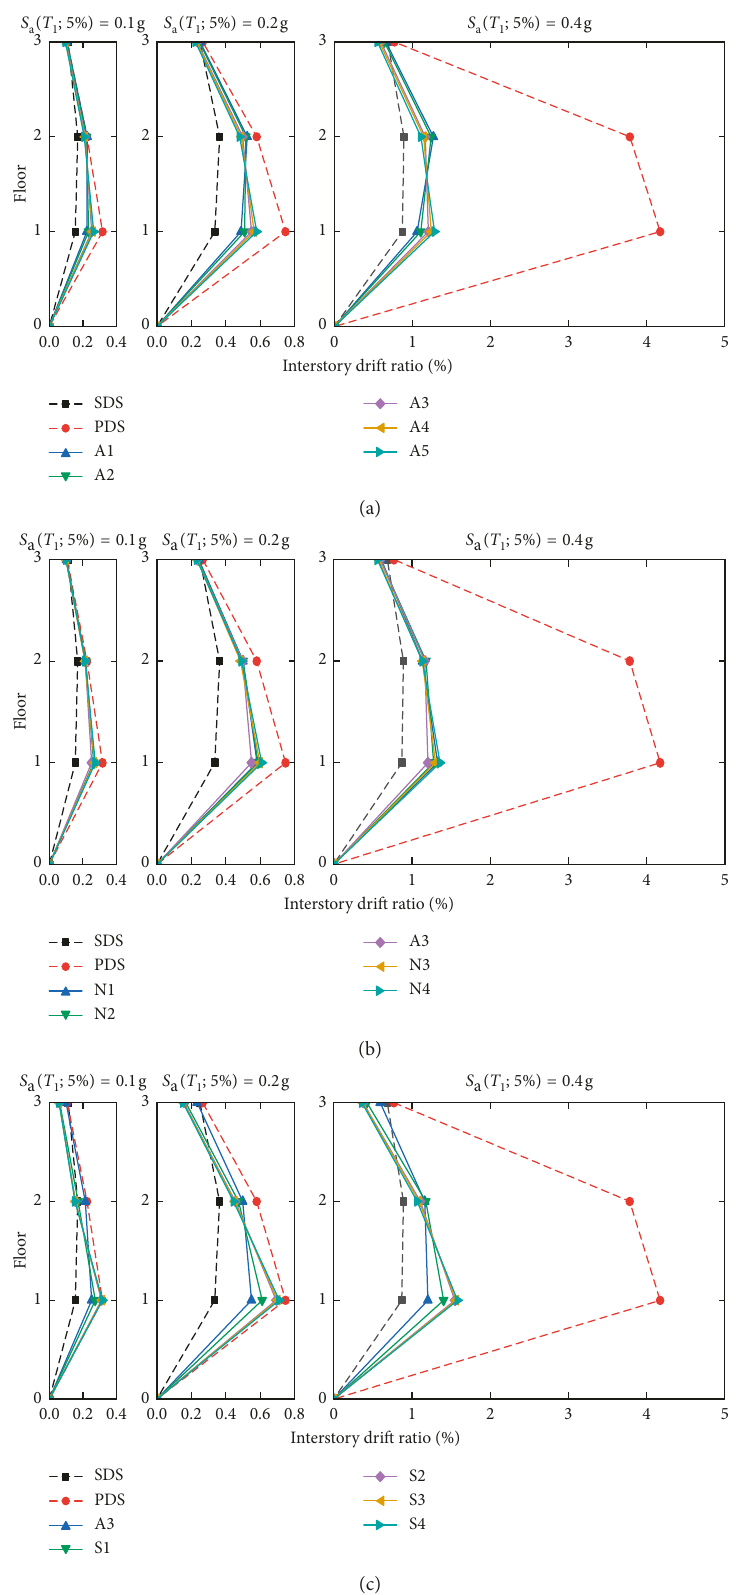
Figure 6: Average of the peak interstory drift ratio of each